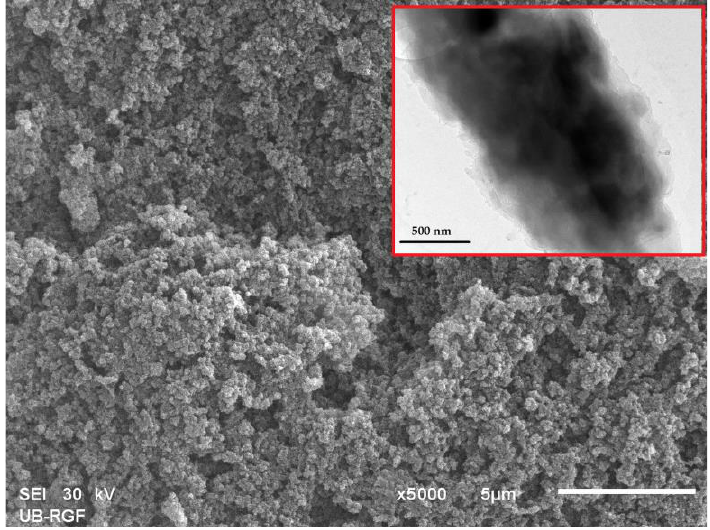
Figure 5. SEM micrograph of cross-section (magnification 5000 × ) and TEM micrograph (inset) of 10MAG-SGE60-deta.